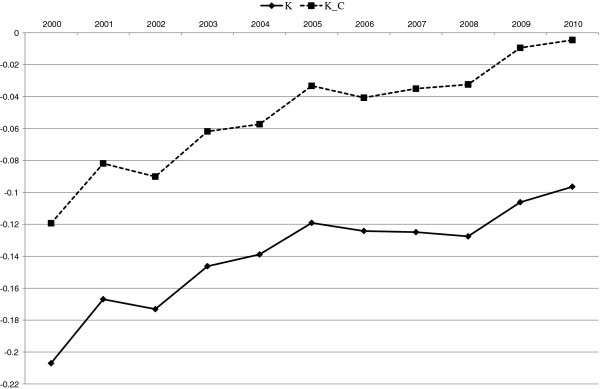
Trend of K and KCfor Medical Services.